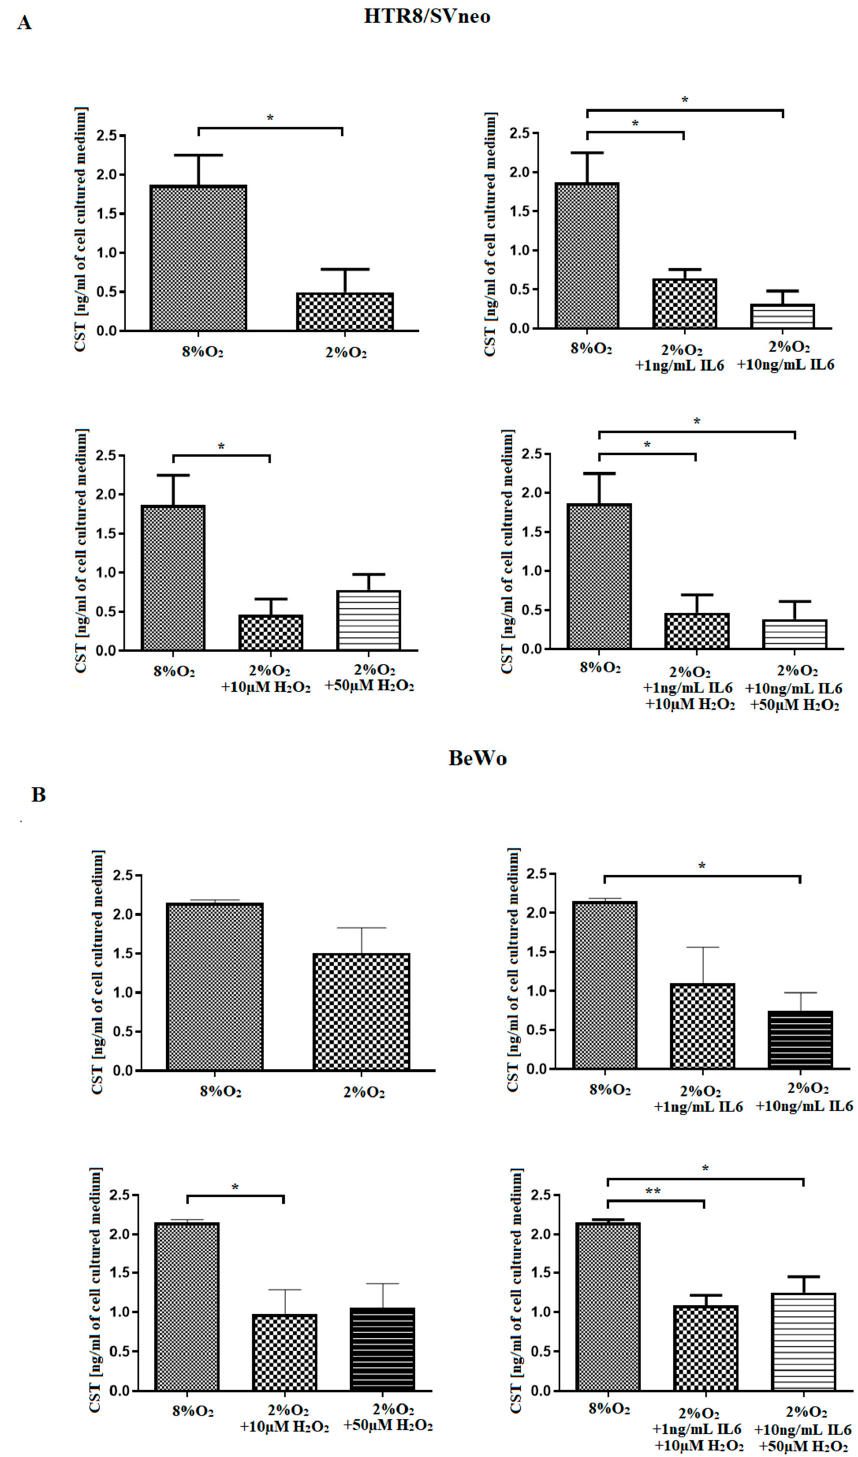
Figure 3. A comparison of CST secreted into the cell medium by hypoxic (2%O 2 ) and normoxic (8%O 2 ) trophoblastic cells, i.e., HTR-8/SVneo ( A ) or BeWo ( B ). CST level was determined in the cell culture medium to test whether CST is secreted by the cells into environment. Thus, the level of CST was determined as ng of studied protein included in 1 mL of cell cultured medium. The results are expressed as ± SEM; n = 3 experiments; the 8%O 2 and 2%O 2 cells were compared using Student’s t -test. The variants and controls were compared using one-way ANOVA with Bonferroni’s multiple comparison test. * p < 0.05 was considered as significant, ** p < 0.01 as compared to